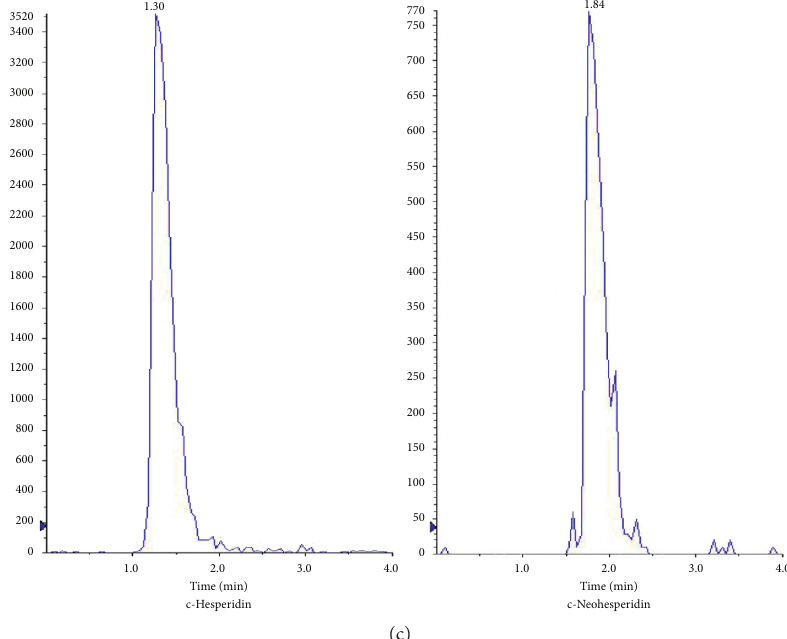
Figure 2: Representative MRM chromatograms: (a) blank plasma; (b) blank plasma spiked with five analytes and IS; (c) real plasma samples after giving a single dose of CHSGS.